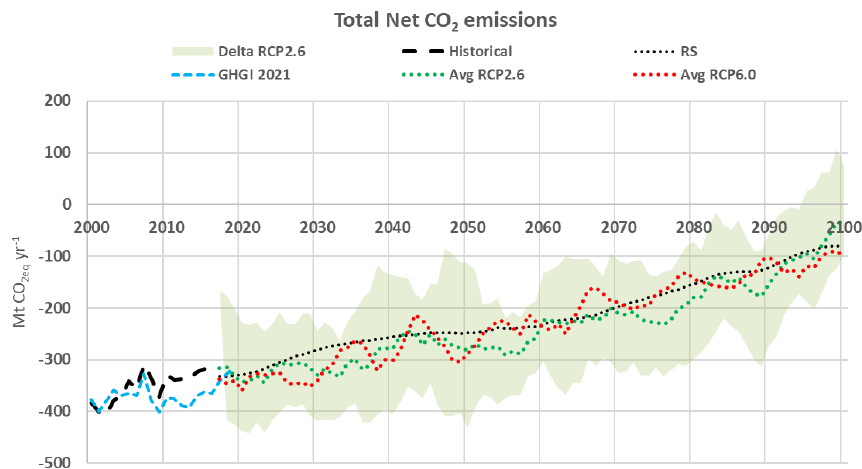
Figure 9. Net CO 2 emissions (reported as MtCO 2eq yr − 1 , with negative values conventionally highlighting CO 2 removals from the atmo- sphere) estimated within the historical period, under the reference scenario (RS) and under RCP2.6 and RCP6.0 (reported as the average values estimated from different climate model within each RCP scenario). The figure also reports the net emissions reported from the EU27 member states and the UK, according to the Greenhouse Gas Inventory 2021 (GHGI 2021, referring to the category Forest Land Remain- ing Forest Land, as reported in UNFCCC CRF Tables, 2021), and the range between the minimum and maximum values estimated under RCP2.6. All values derived from the present study are reported as 5-year moving averages, referring to the category Forest Land Remaining Forest Land, excluding HWP net